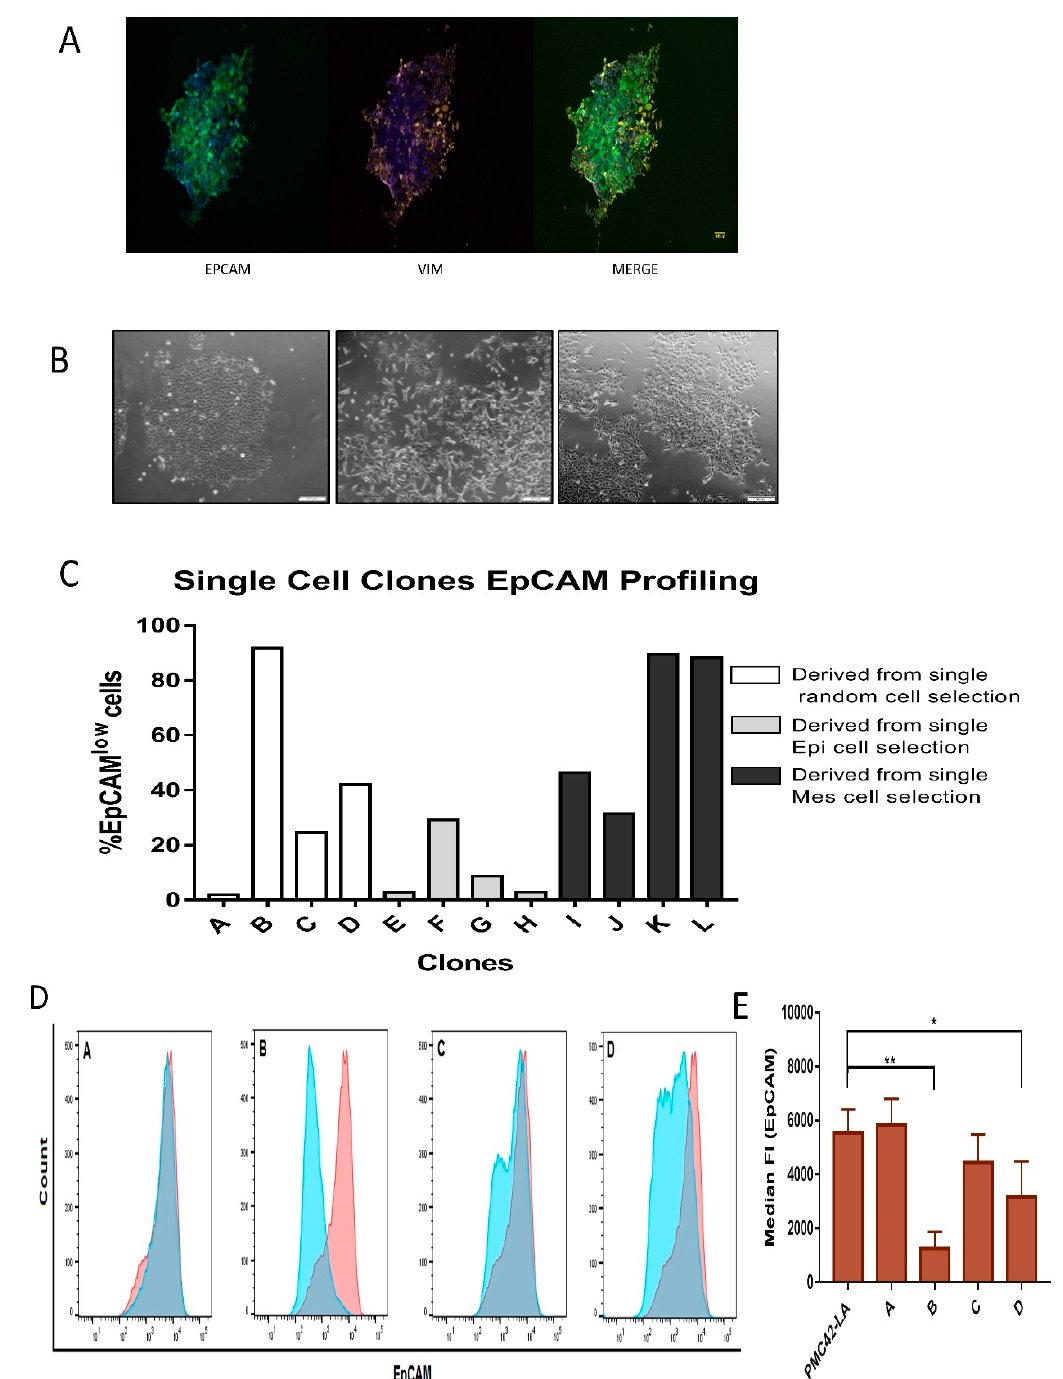
Figure 5. ( A ) EpCAM expression on the cellular junctions and concomitant vimentin-positive cells growing out from an individual cell derived clone (pictures were taken after three weeks of single- cell clonal propagation). ( B ) Morphological assessment of epithelial clustered colony, mesenchymal segregated cells, and mixed epithelial and elongated colonies obtained from clonal propagation of single cells after gating for EpCAM low and EpCAM high cells after the first passage. Scale bar, 200 µM. ( C ) FACS profiling for EpCAM results in distribution of EpCAM low and high cells at variable ratios across various single cell-derived clones. ( D ) Histograms depicting the proportion of EpCAM high and EpCAM low cells in the four selected clones as overlap with parental EpCAM profile (red). ( E ) Staining intensity of EpCAM for the clones and parental PMC42-LA cells assessed by median fluorescence intensity unit ( n = 4). Significant di ff erences were calculated by one-way ANOVA and nonparametric Dunnett’s multiple comparisons test. * P < 0.05, ** P <